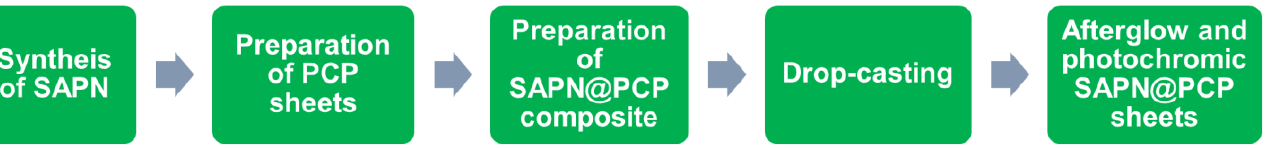
Figure 1. Scheme illustrating the manufacture of PCP films